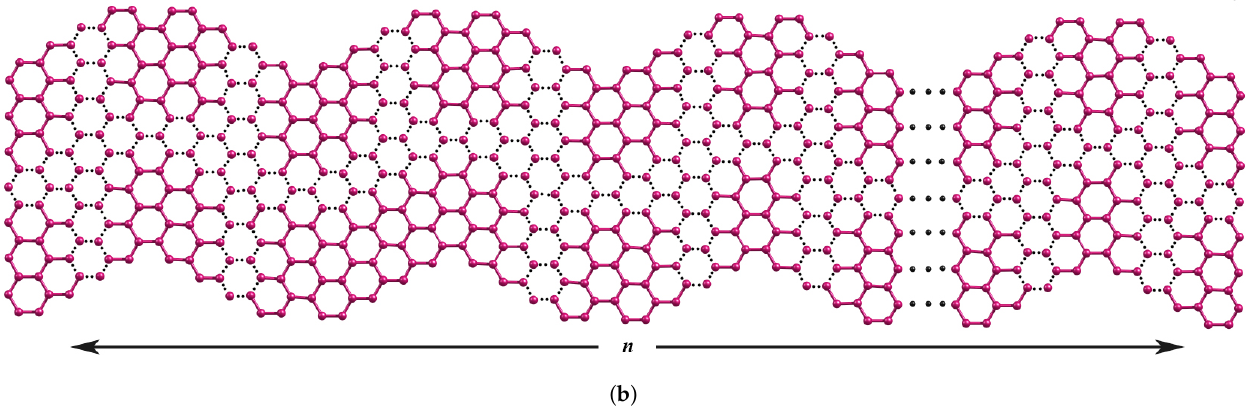
Figure 1. ( a ) Zigzag edges of nanographene ZNR ( r , c ) ( b ) n -wave series of WNR ( r , c , n )